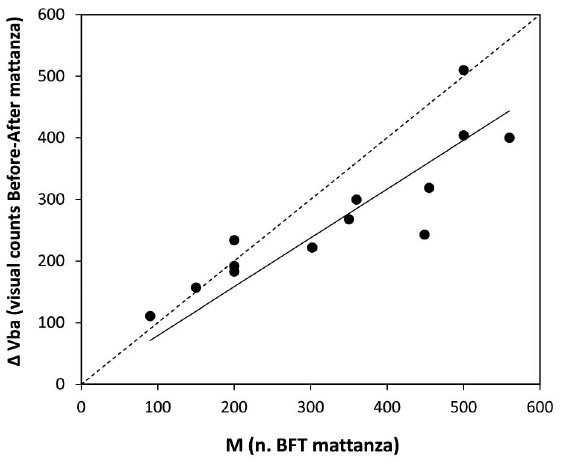
Fig. 2. – Scatterplot between the number of specimens captured dur- ing each mattanza (M) and the number of visual counts taken before and after the mattanza ( Δ V ). The expected value is represented ba by the dotted line (i.e. the bisector) corresponding to M= Δ V the straight line is the fitted regression curve from observed data ( Δ V =0.7922*M; r 2 ba